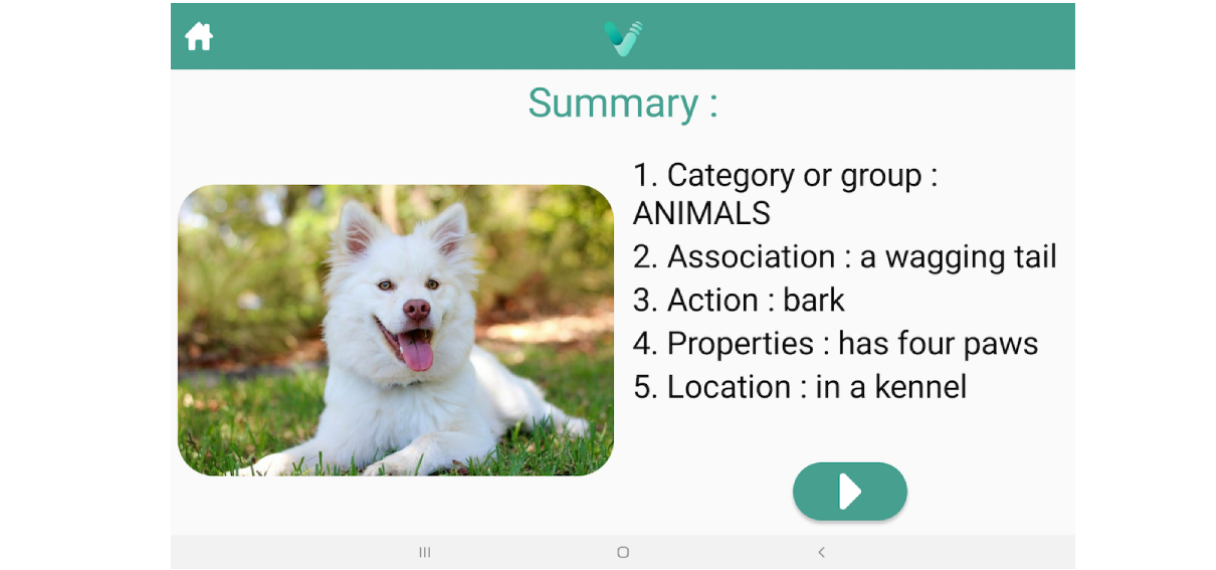
Figure 2. Screenshot from the VoiceAdapt app displaying the summary screen of the Semantic Feature Analysis protocol.